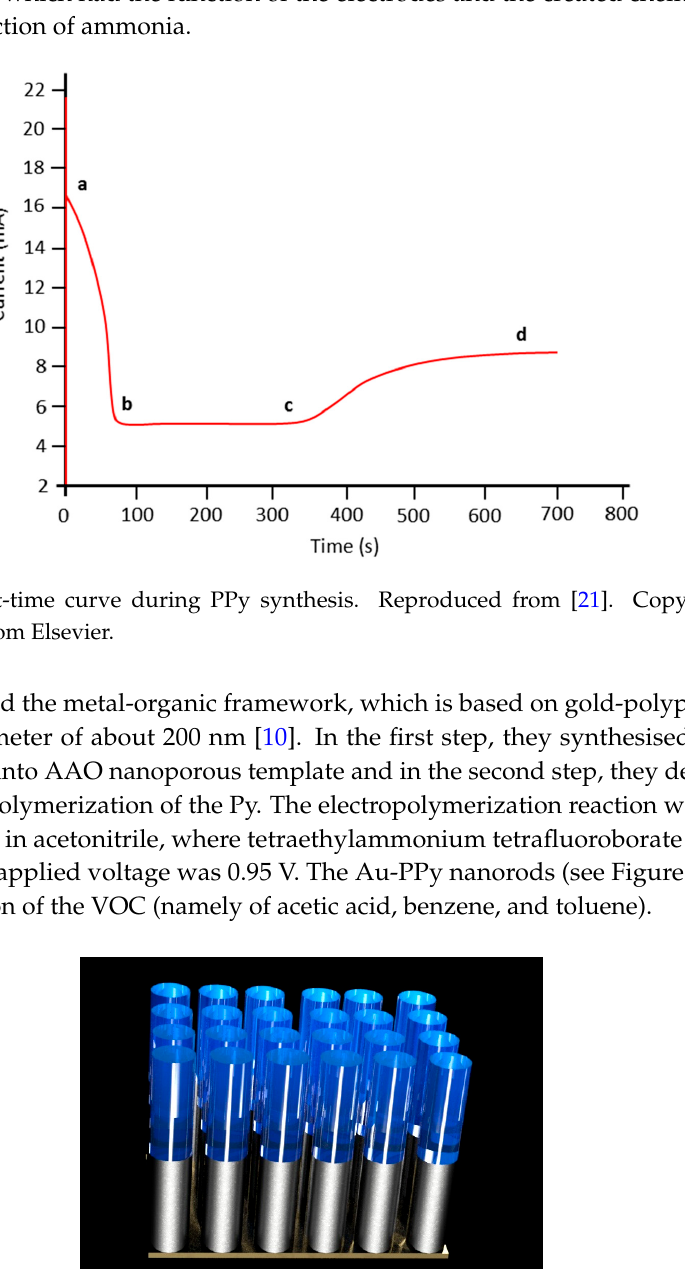
Figure 7. Schematic illustration of Au-PPy nanorods.